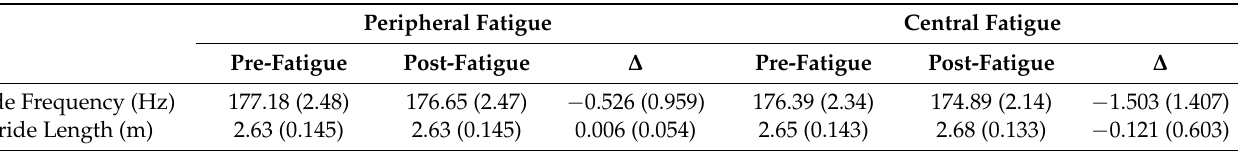
Table 2. Results (mean and standard deviation) of the stride frequency and stride length, pre- and post-fatigue.